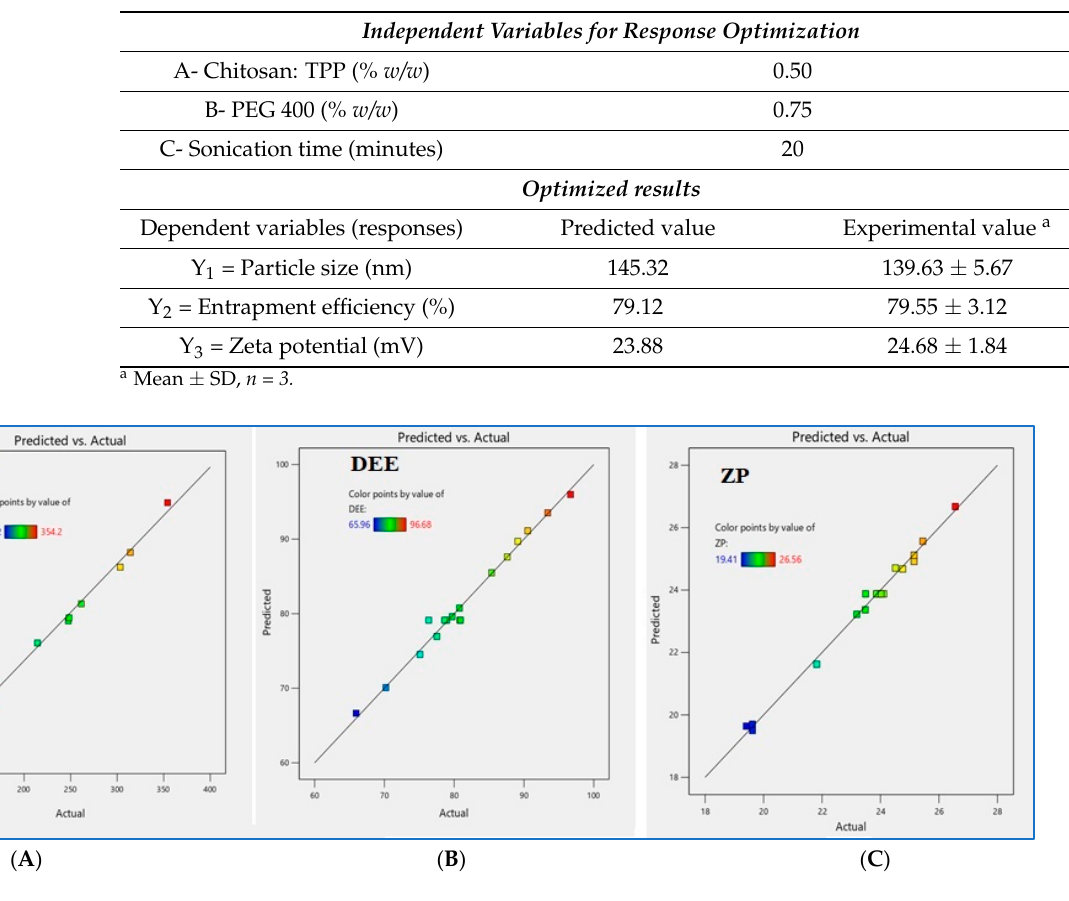
Figure 4. Predicted vs. actual plot representing the effects of X 1 and X 2 on the measured responses at the mid-level of X 3 on ( A ) PS (Y 1 ), ( B ) DEE (Y 2 ), and ( C ) ZP (Y 3 ). Table 5. Results of optimization of APG-loaded PEGylated-CNPs prepared under optimum condi- tion.